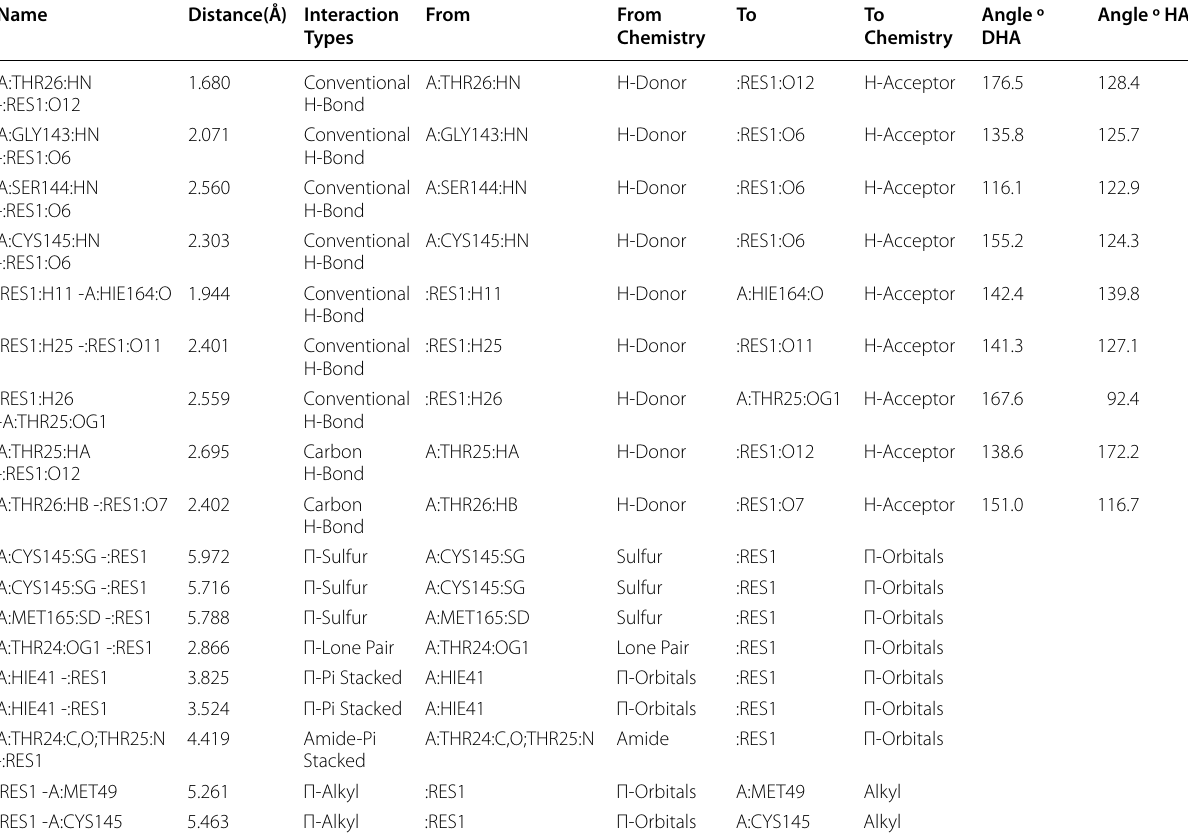
Table 2 Interaction types with surrounding amino acids of SARS CoV 2 Main Protease (PDB ID: 6XBH) with inhibitor Index number 331 Name Distance(Å) Interaction From From To Types Chemistry